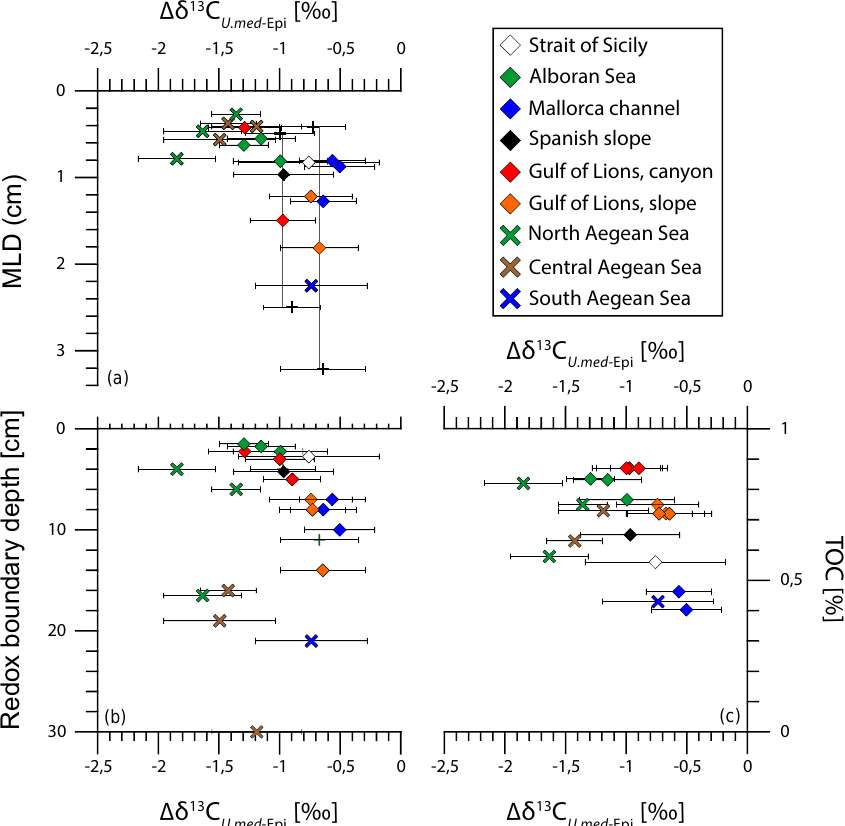
Figure 4. The δ 13 C difference between live Uvigerina mediterranea and epifaunal taxa ( (cid:49)δ 13 C Umed-Epi ) plotted against (a) MLD of U. mediterranea , (b) depth of redox boundary in the sediment, and (c) TOC content of the sediment. The MLD error bars for the canyon and slope sites in the Gulf of Lion reflect the seasonal MLD contrasts of U. mediterranea between February and August 1997 (Schmiedl et al.,